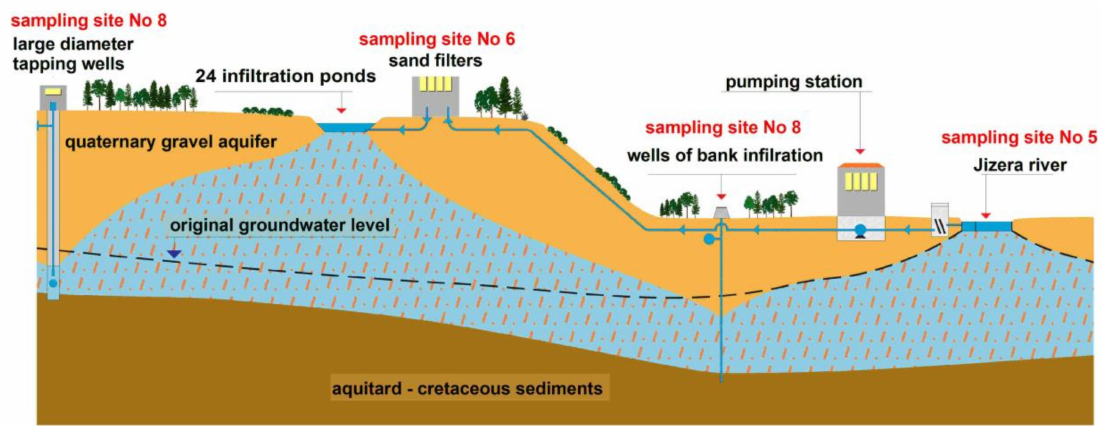
Figure 2. Scheme of K á ran ý waterworks (modified from Skalick ý